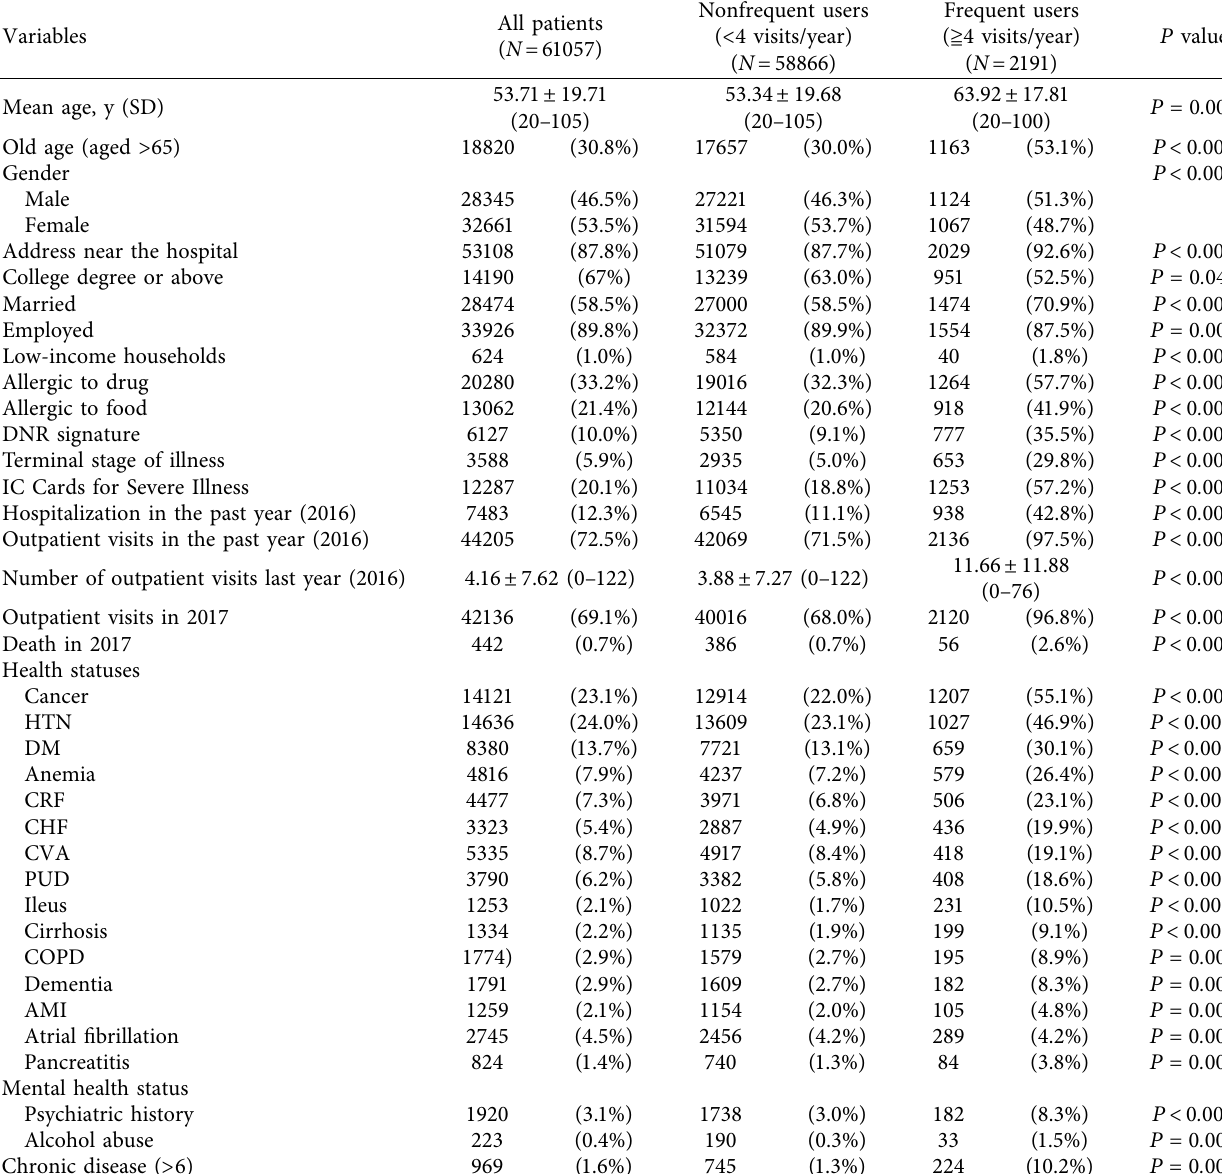
Table 1: Baseline demographics and characteristics of frequent and nonfrequent